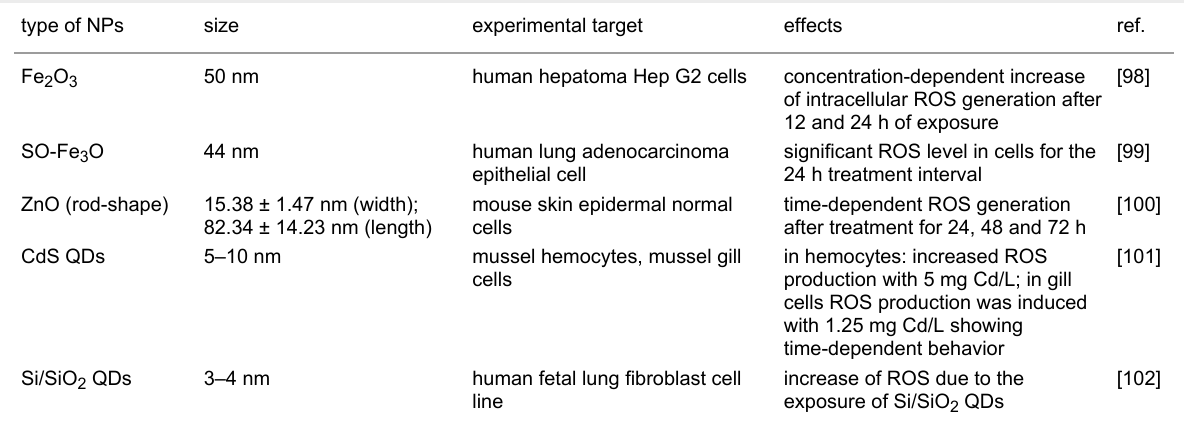
Table 2: Oxidative stress caused by NPs in different cells and